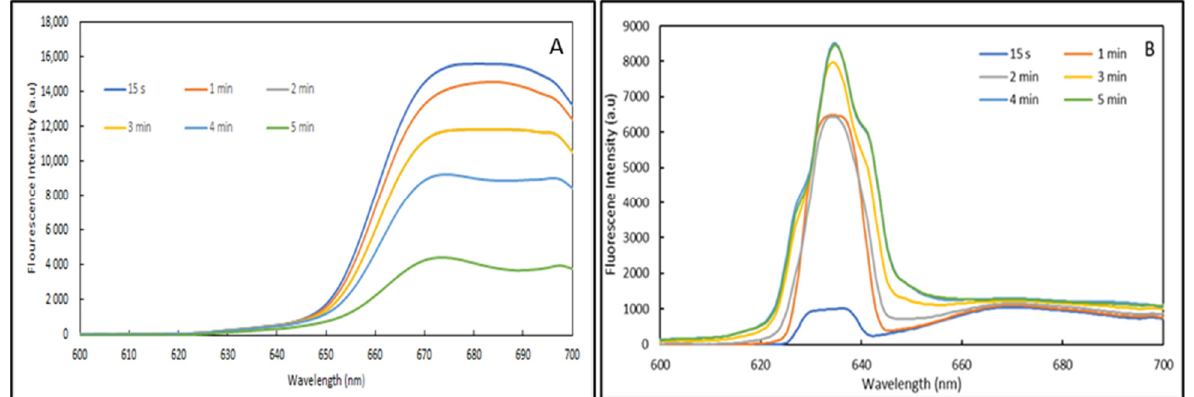
Figure 9. Emission spectra of Atto 633 dye at 0.1 mW at ( A ) 1.2 × 10 −5 g/mL and ( B ) 1.2 × 10 −6